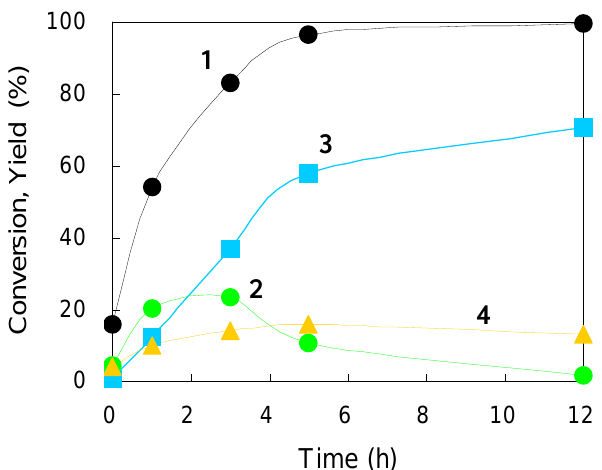
Figure 1. Typical time course of reactions of cyclohexene with CO